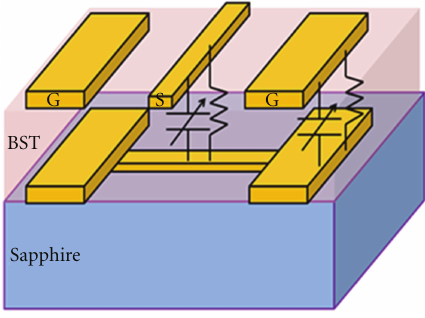
Figure 2: BST thin-film varactor